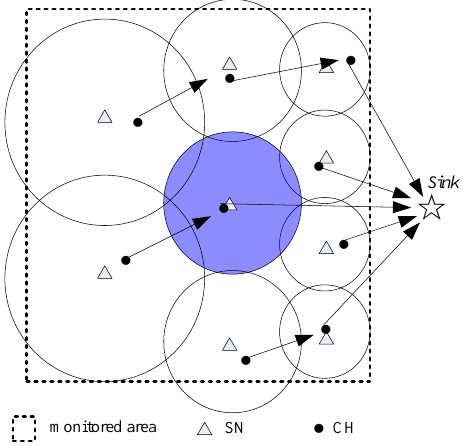
Figure 2. The energy-harvesting wireless sensor network (EH-WSN) model used in this paper. CH: cluster head; SN: scheduling